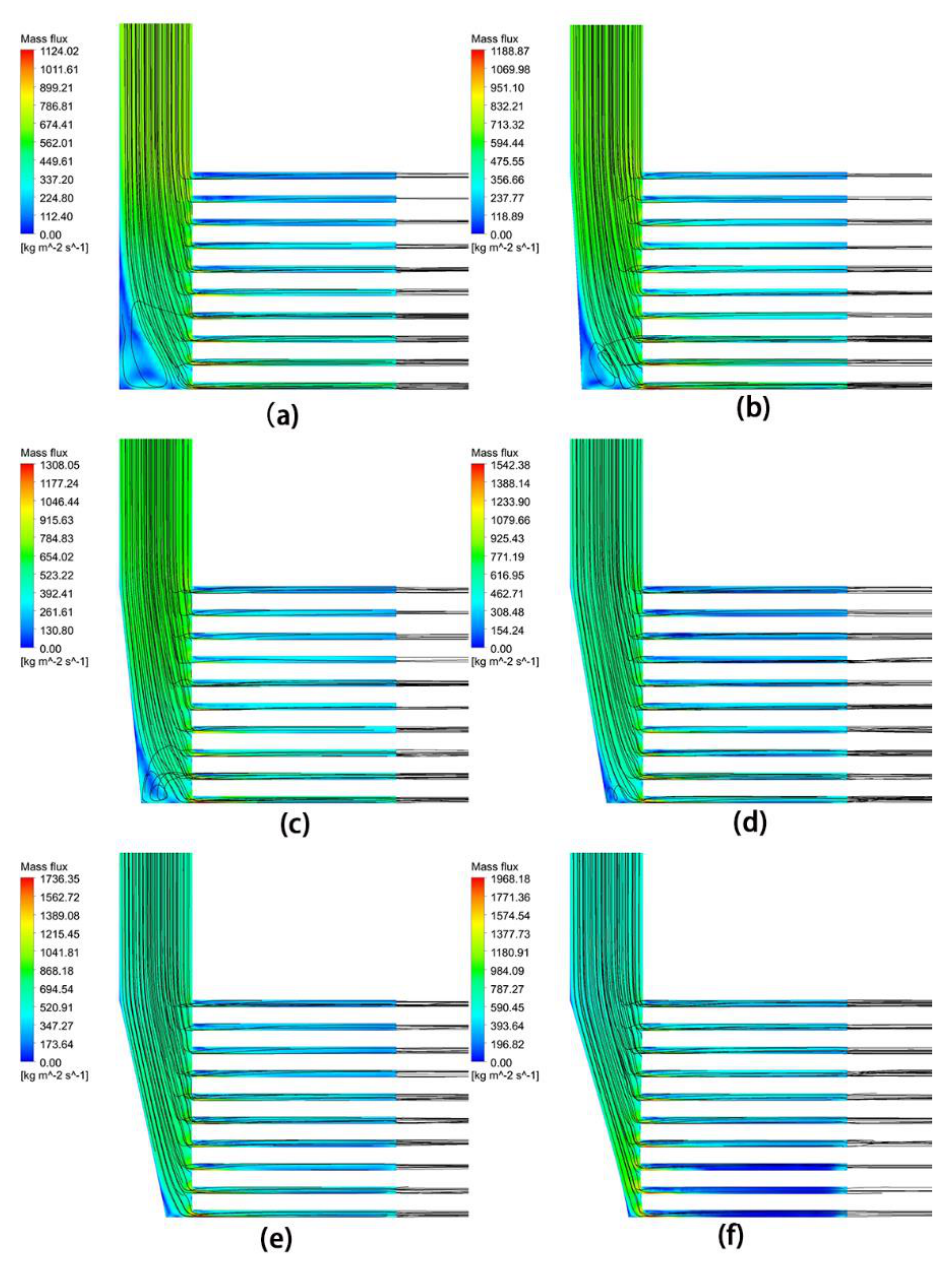
Figure 11. Mass flow rate cloud diagram and flow diagram of the headers with different angles. ( a )